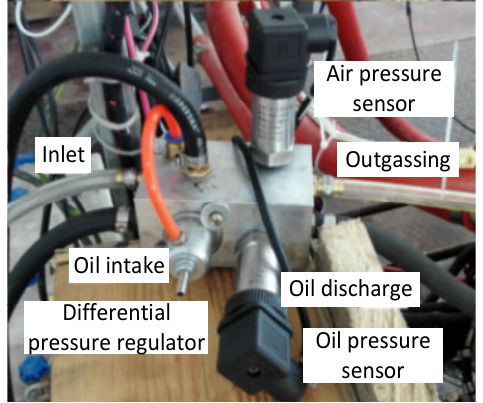
Figure 4. Photograph of the experimental prototype.